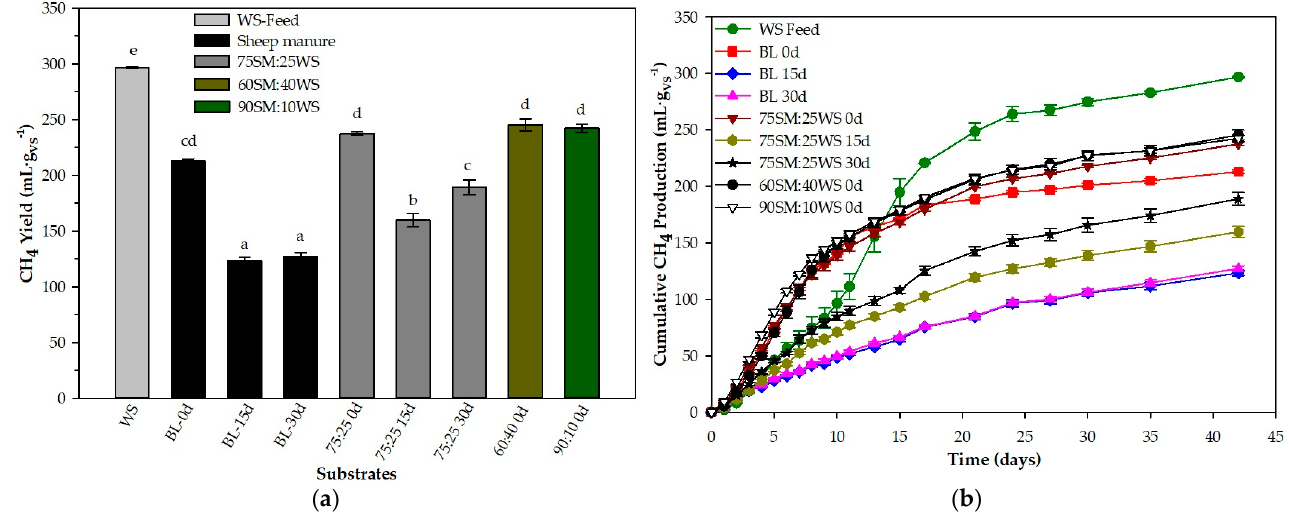
Figure 2. Methane yields ( a ) and cumulative methane productions ( b ) from the anaerobic mono- and co-digestion of each substrate. Different letters above the bars signify distinct statistical groups ( p < 0.05) between the different tests. The bars designate the standard deviation.